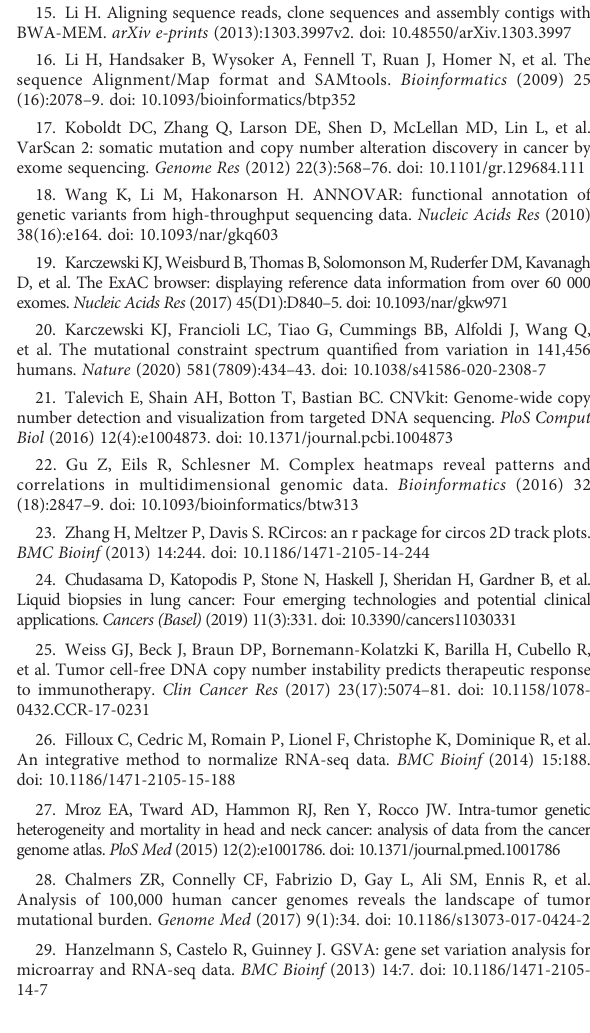
SUPPLEMENTARY FIGURE 3 Immunohistochemical staining for the key genes EGFR and HSP90AA1in normal tissues, READ tissues and COAD tissues. (Image credit: Human Protein Atlas, images available from